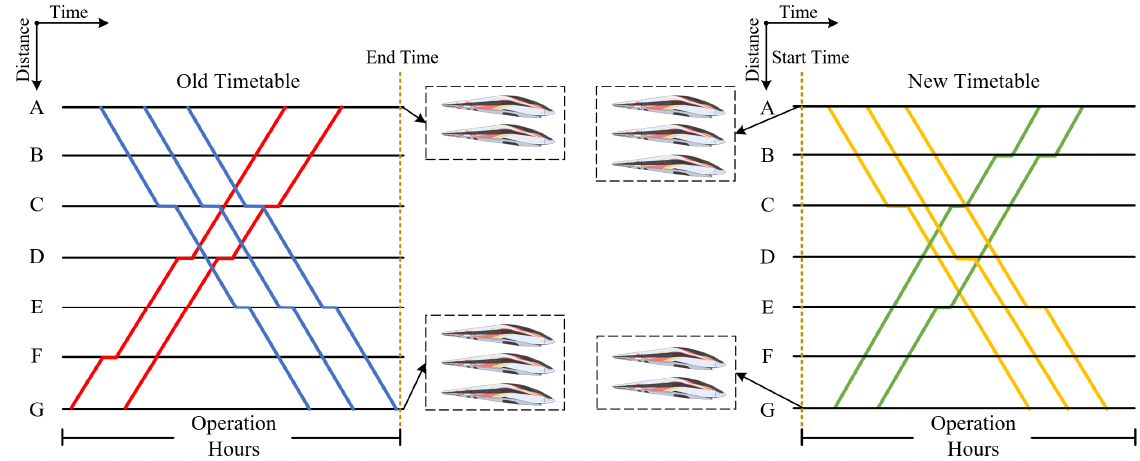
Figure 2. The schematic diagram of the old state and the new state.